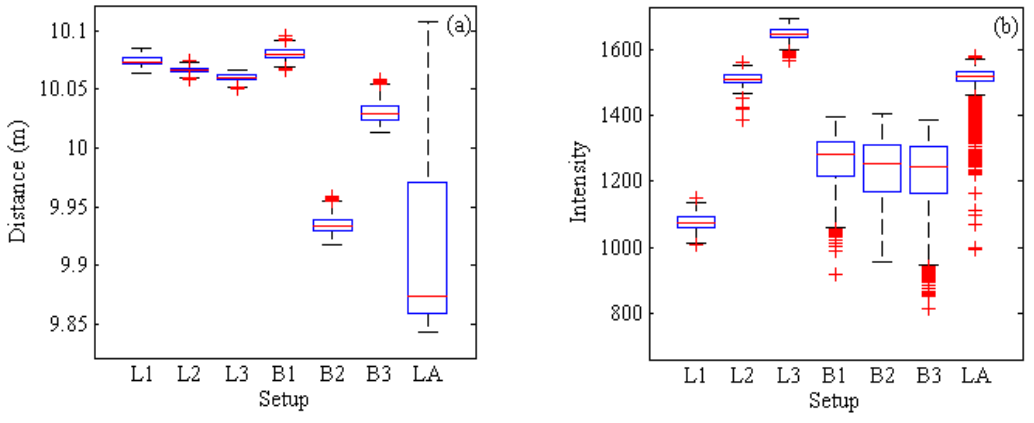
Figure 7. Boxplot of ( a ) distance and ( b ) intensity of valid scan points per setup. L1: leaf reflectance 10%, L2: leaf reflectance 50%, L3: leaf reflectance 90%, B1: branch diameter 0.05 m, B2: branch diameter 0.08 m, B3: branch diameter 0.1 m, LA: layers setup. The box represents the interquartile range of the data (the 25th and 75th percentiles), and the whiskers represent the inner 10th and 90th percentiles. Reference configuration from Table 1 was used: scanning distance = 10 m; incident angle = 0°; scanning resolution = 1:2. Outliers are represented by plus (+)